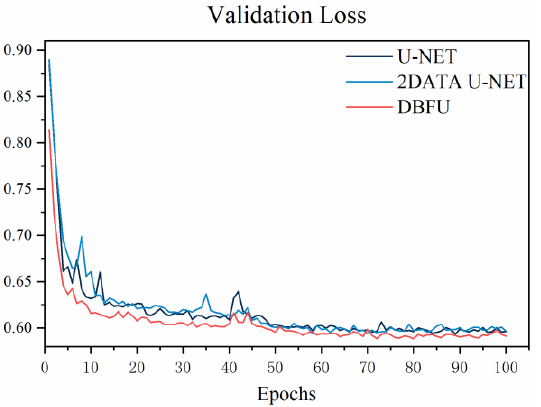
Figure 11. Comparison of validation loss of U-NET, 2DATA U-NET and DBFU (Y-axis: the value of the validation loss in training process).